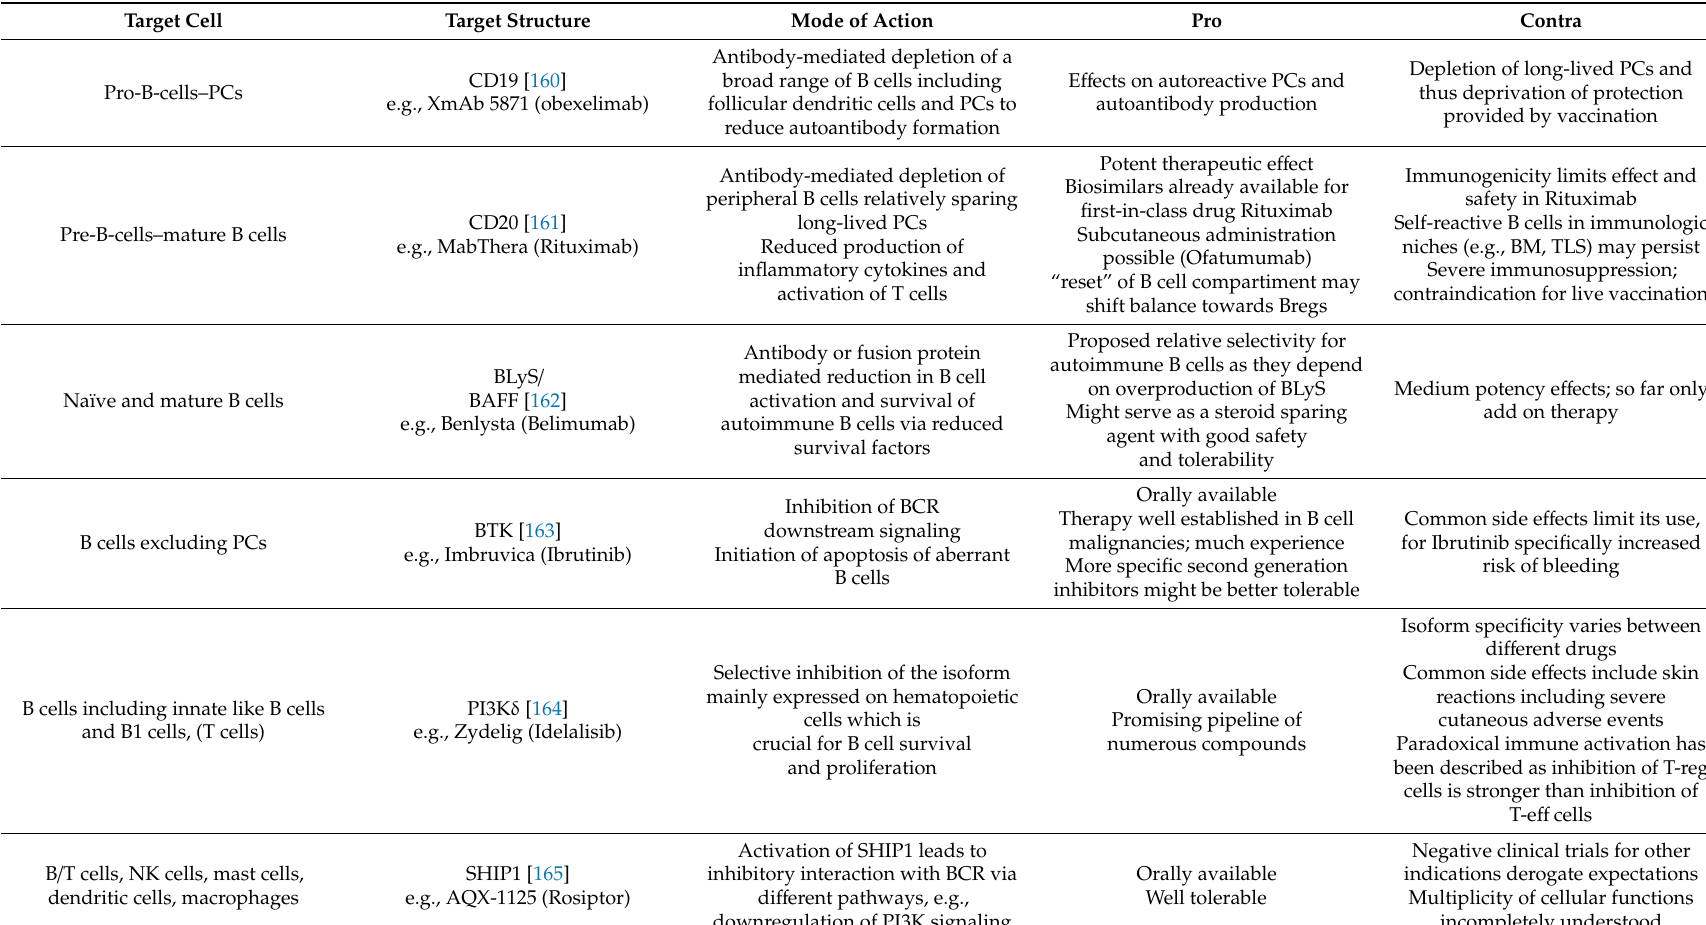
Table 1. Exemplary B-cell- and plasma cell (PC)-associated therapeutic strategies and their advantages and disadvantages in regard to cutaneous autoimmune diseases. Another mode of therapeutically modifying B cell e ff ects is via elimination of pathogenic immunoglobulins (e.g., plasmapheresis,